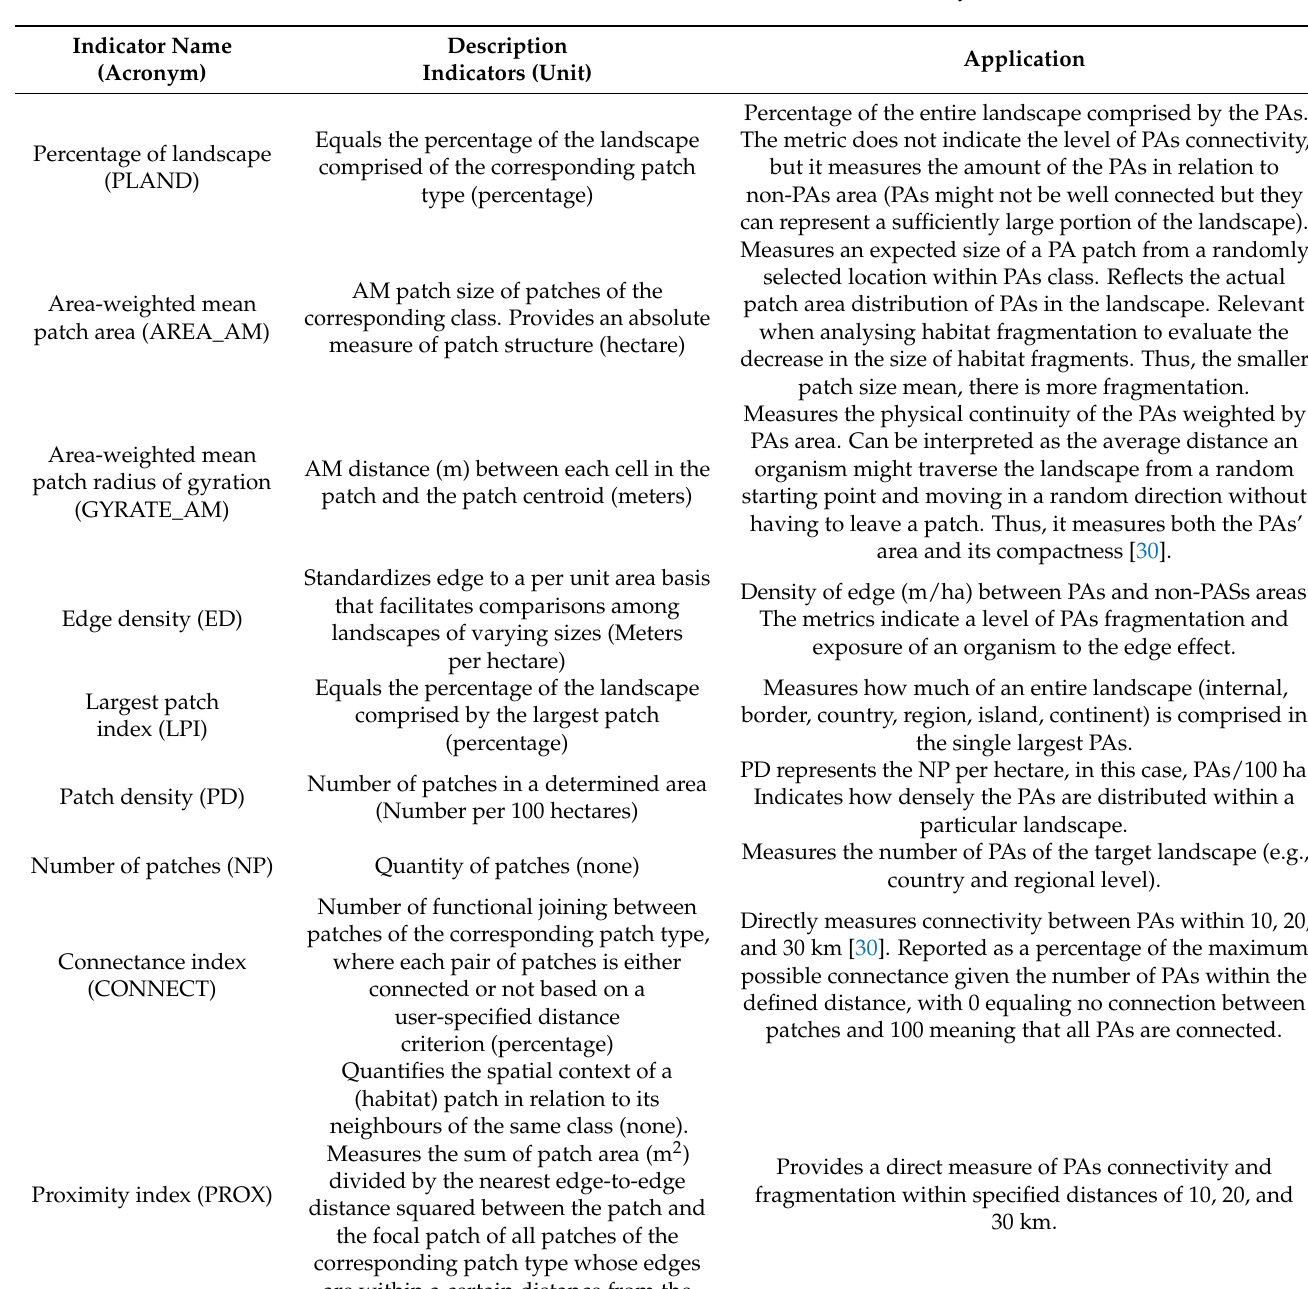
Table 1. Overview of the FRAGSTAT metrics used for the analysis. See Methods for further